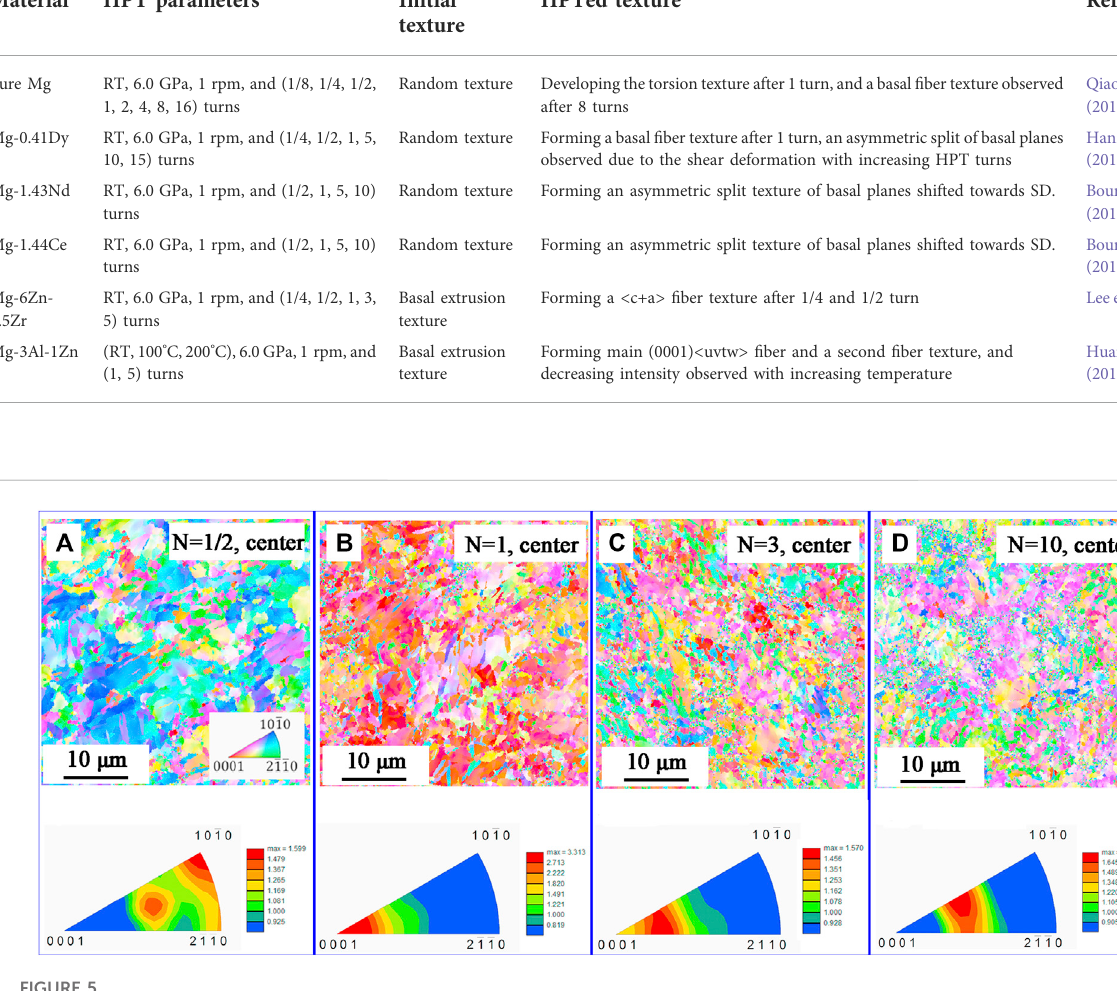
FIGURE 5 Grain orientations and inverse pole fi gures of AM60 alloys with (A) 1/2 turn, (B) 1 turn, (C) 3 turns, and (D) 10 turns (Khaleghi et al.,